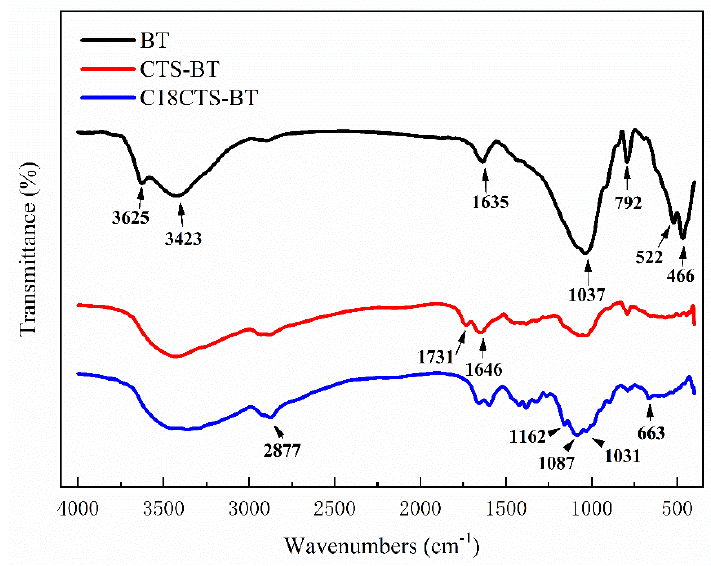
Figure 2. FT − IR of the Figure 2. FT−IR of the adsorbents.